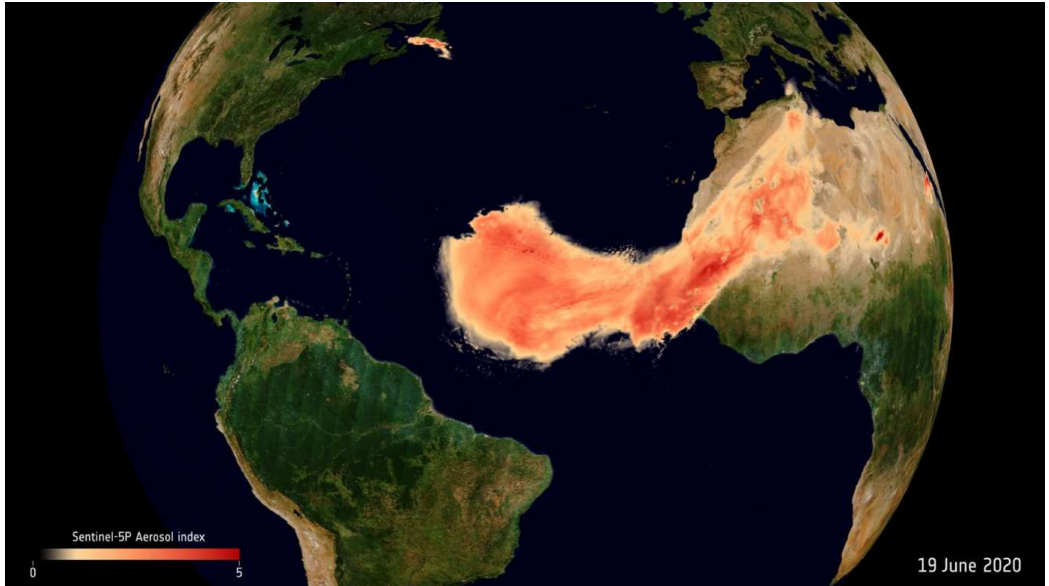
Figure 5. Data from the Copernicus Sentinel satellites and ESA’s Aeolus satellite show the extent of this year’s summer dust plume, dubbed “Godzilla,” on its journey across the